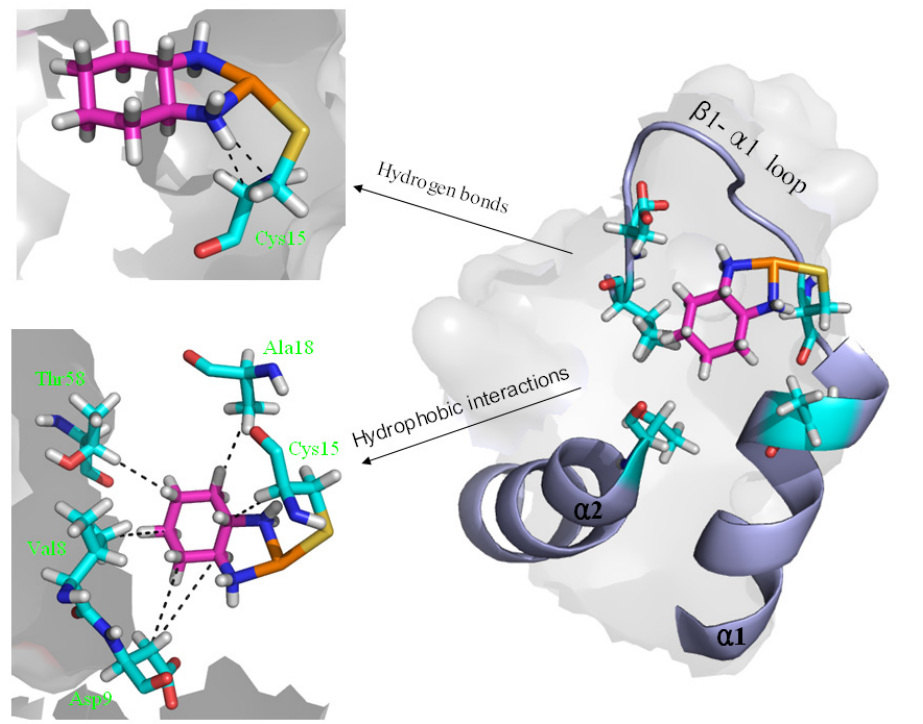
Figure 6. The scheme of the extra hydrogen bond and hydrophobic interactions for the OxaliPt + Atox1 model. (Pt: orange; N: deep blue; C: cyan/magenta; S: yellow; O: red; H: